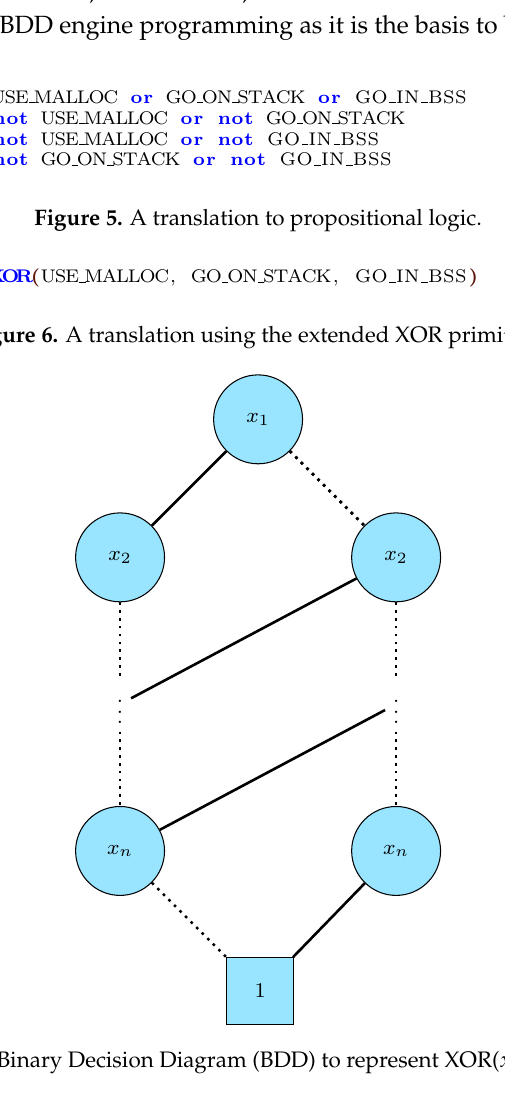
Figure 7. A Binary Decision Diagram (BDD) to represent XOR( x 1 , x 2 , . . . , x n